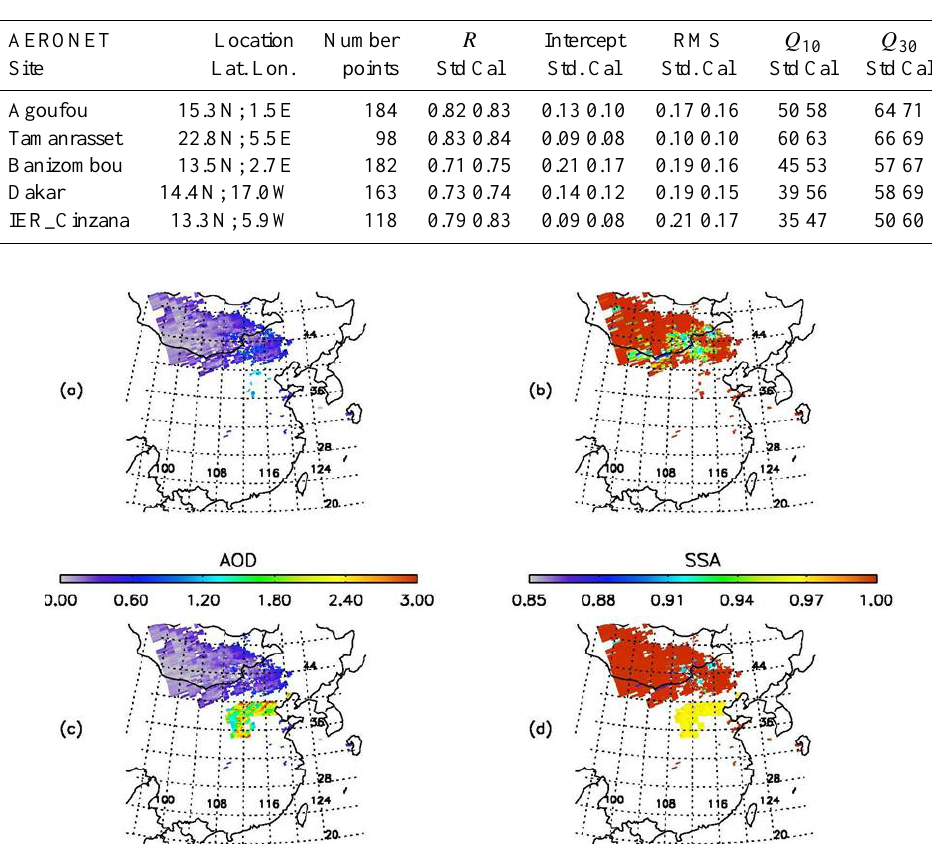
Fig. 8. Retrieved AOD and SSA at 388nm from the previous (a, b) and improved (c, d) OMI UV algorithm over northeastern China on 20 August